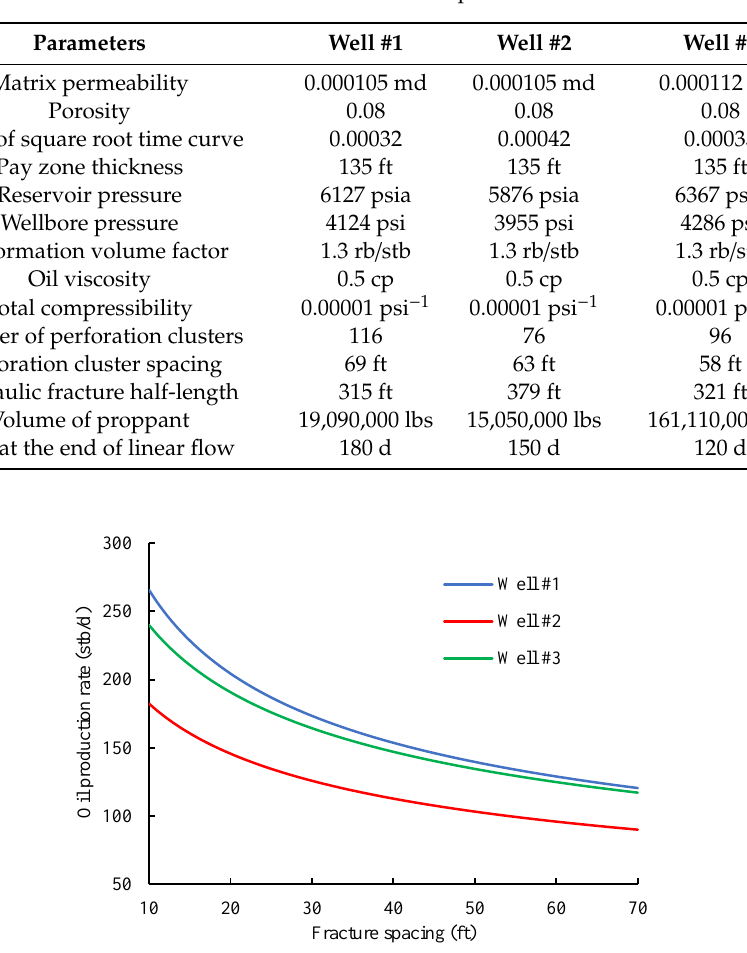
Table 1. Reservoir and well completion data.